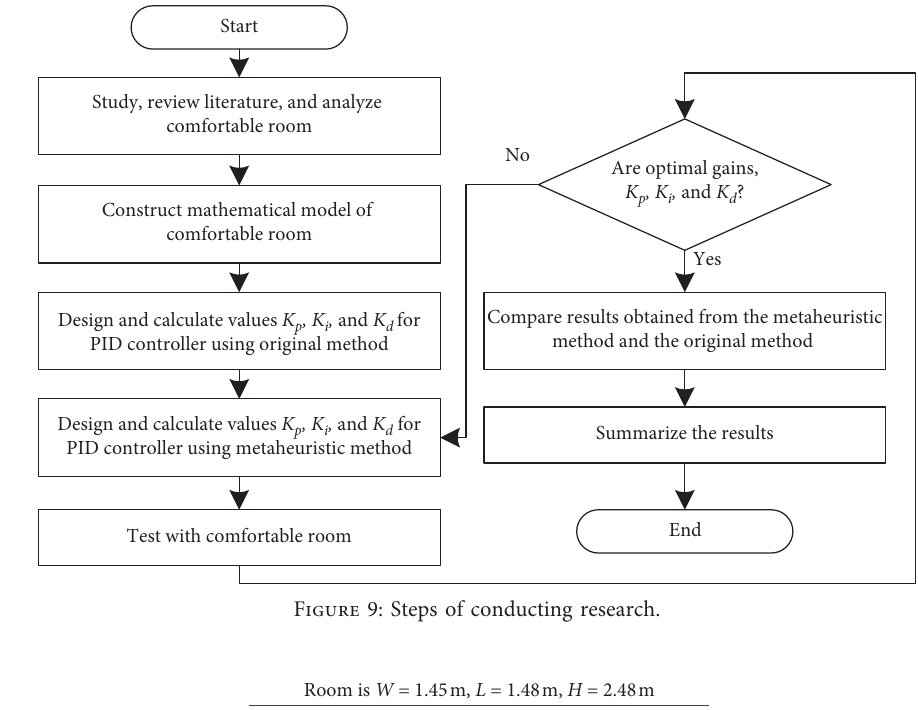
Figure 9: Steps of conducting